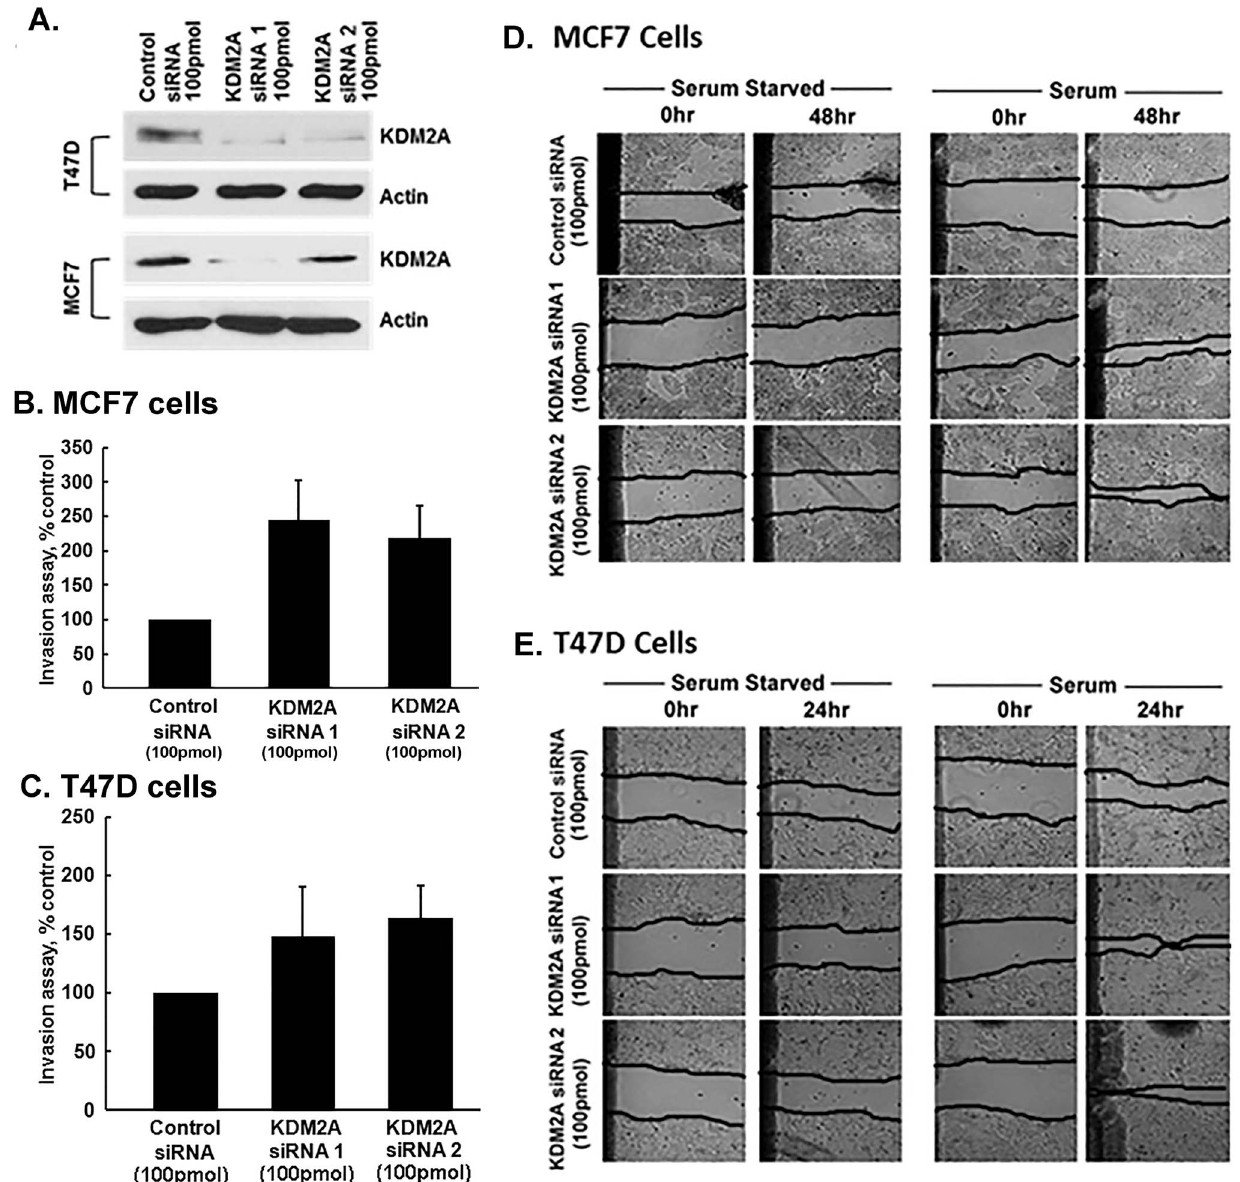
Figure 2. KDM2A suppresses invasion and migration of breast cancer cells. (A) Western blot analysis showing decreased KDM2A levels in T47D and MCF7 cells with two different siRNAs to KDM2A (Ambion and Santa Cruz) compared to control siRNA. (B) Silencing KDM2A by KDM2A siRNA 1 increased invasion in MCF7 cells by 145 6 23% (p , 0.05) and KDM2A siRNA 2 increased invasion by 118 6 21% (p , 0.05) when compared to control siRNA. (C) In T47D cells, KDM2A siRNA 1 enhanced invasion by 48 6 28% (p , 0.1) and KDM2A siRNA 2 by 64 6 16% (p , 0.05) when compared to control siRNA. (D) Both KDM2A siRNA1 (100 pmol) and KDM2A siRNA2 (100 pmol) transfected MCF7 cells migrated into the wound in the presence of serum at 48 hr when compared to control siRNA transfected cells. Serum starved cells did not migrate into the wound with or without KDM2A suppression. (E) T47D cells additionally show significant migration into the wound after transfection with KDM2A siRNA1 and KDM2A siRNA 2 in the presence of serum at 24 hr when compared to control siRNA. Serum starved cells did not migrate into the wound with or without